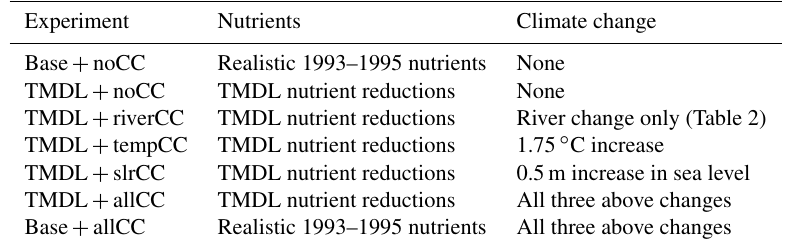
Table 1. Definitions of sensitivity experiments.